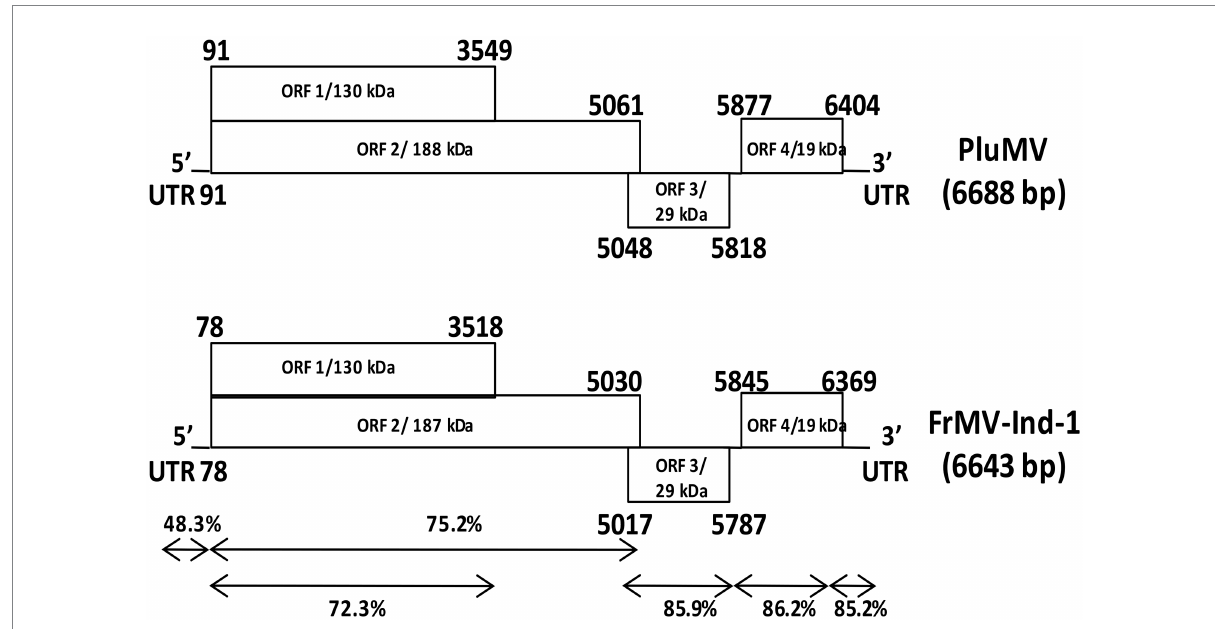
FIGURE 3 Comparison of the genome structure of plumeria mosaic virus (pluMV-Plu-Ind-1) and Indian isolate of frangipani mosaic virus (FrMV-Ind-1). The percent identities between the coding and non-coding regions of the two viruses are indicated with